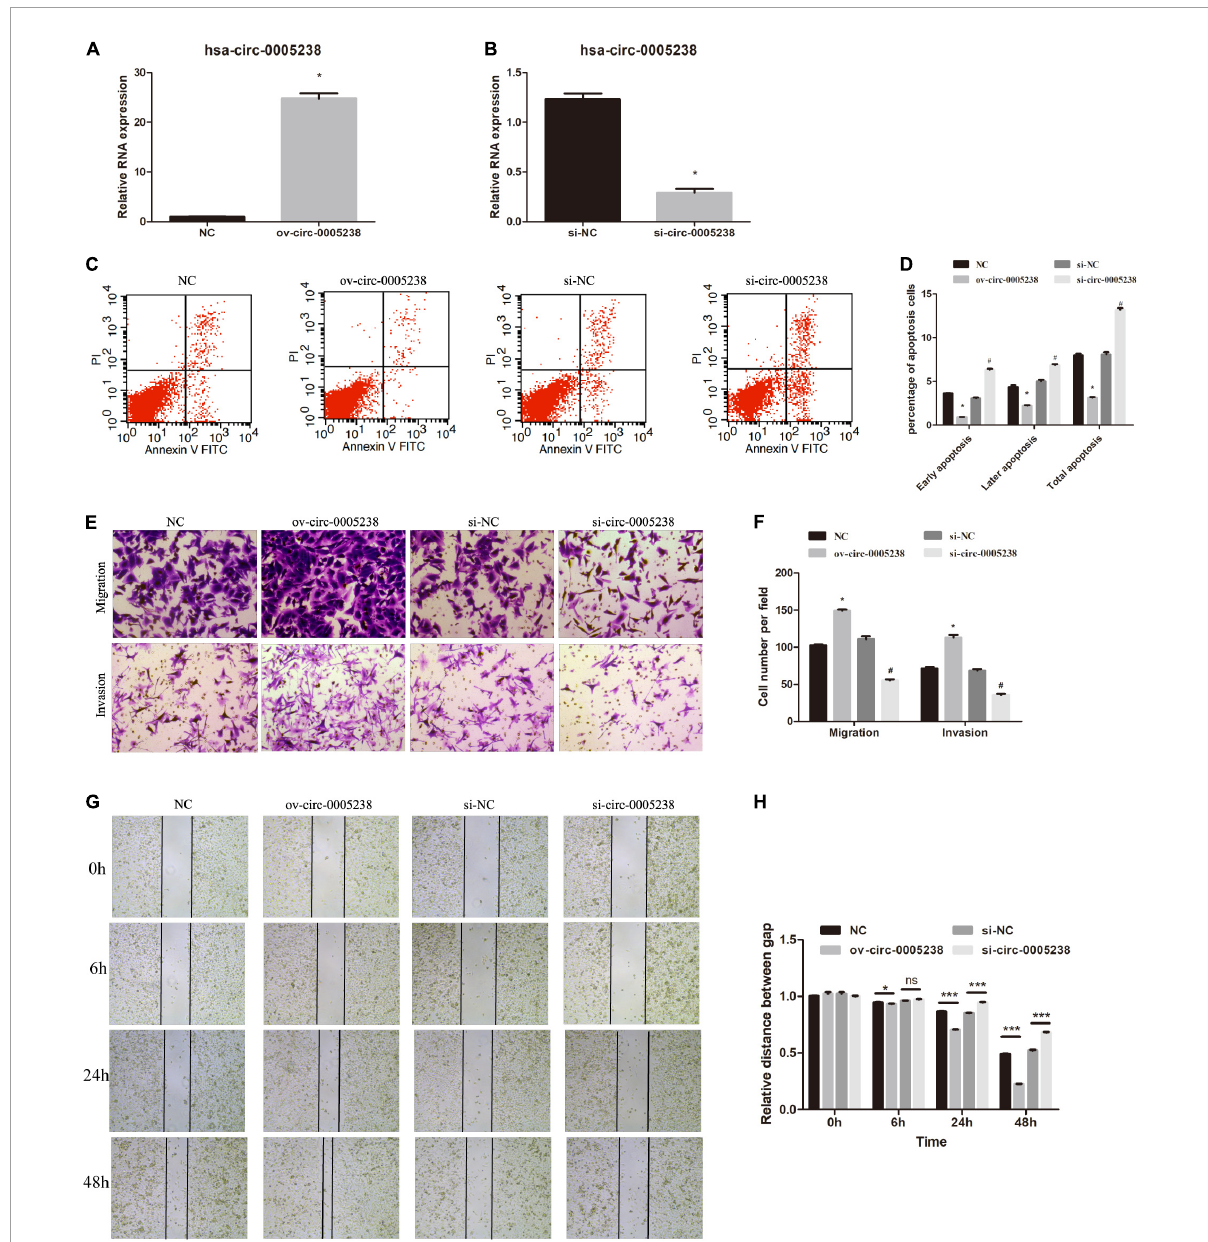
FIGURE4 Effect of hsa-circ-0005238 overexpression or knockdown on biological functions of HTR-8 cells. (A) Hsa-circ-0005238 is overexpressed in HTR-8 cells after transfection ov-circ-0005238 compared to NC. (B) Hsa-circ-0005238 expression is knockdowned in HTR-8 cells after transfection with siRNA compared to si-NC. (C) Representative graphs of the apoptosis. (D) Quantification of the percentage of apoptotic cells. (E) Representative images of migration and invasion by Transwell assay and Boyden assay. (F) The quantification of migrated or invaded cell numbers. (G) Representative images of wound healing assay. (H) The relative distance between gap. # P < 0.05, * P < 0.05, *** P <